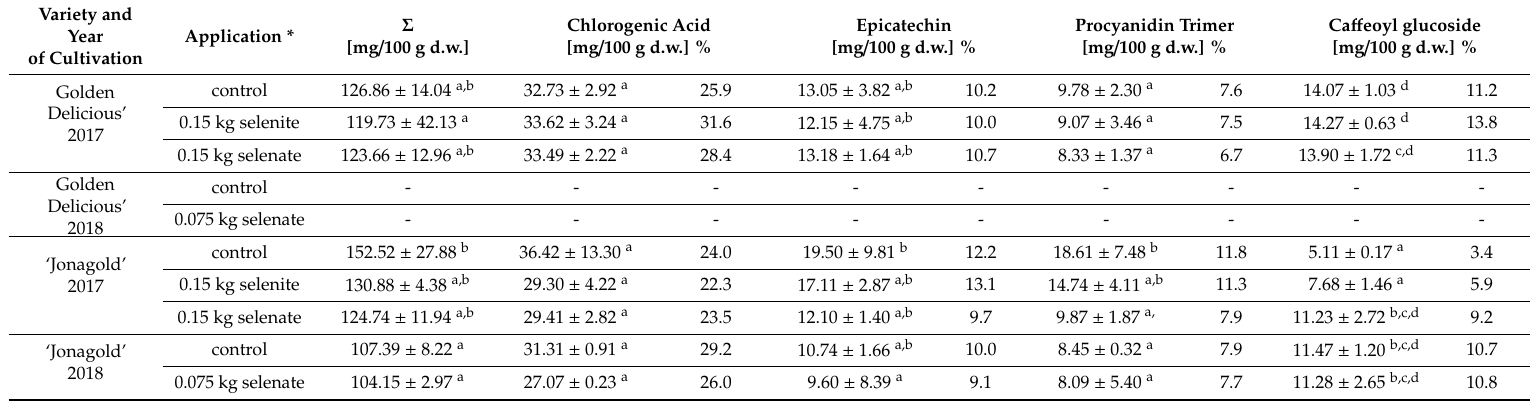
Table 2. Results of the determination of phenolic compounds using HPLC-MS n . Data are in average ± standard deviation. The total phenolic content in mg / 100 g d.w. was calculated by the sum of all quantitative determined phenolic compounds. For the four main phenolic compounds the content in mg / 100 g d.w. and the percentage share is given. In each column, means followed by di ff erent letters are significantly di ff erent ( p <